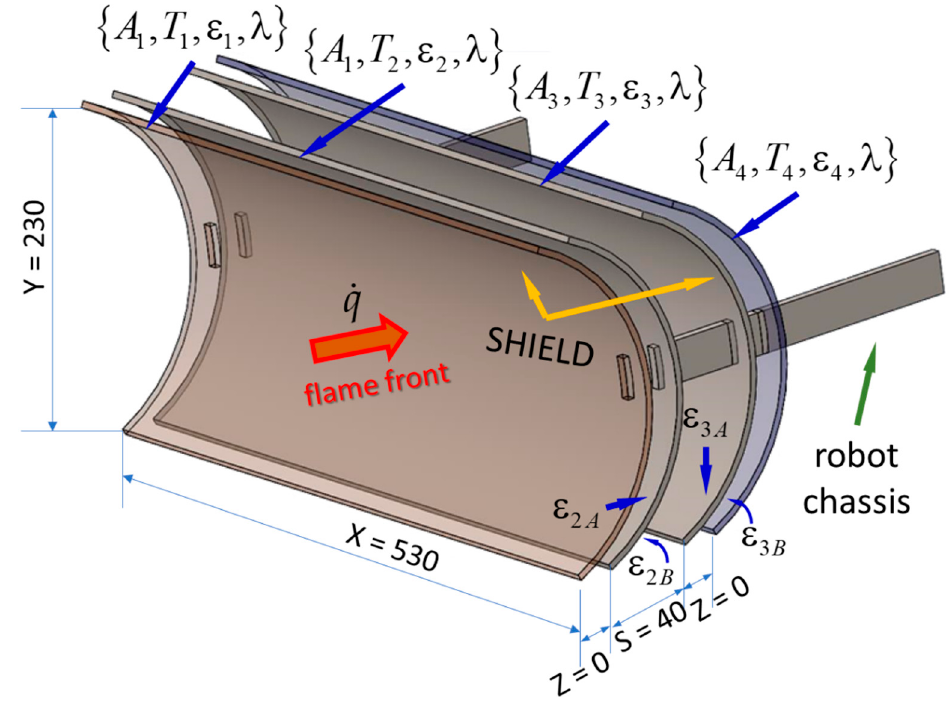
Figure 1. Radiation Shield between two parallel planes.